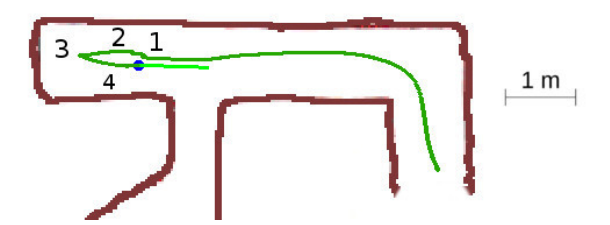
Figure 17. Dead end